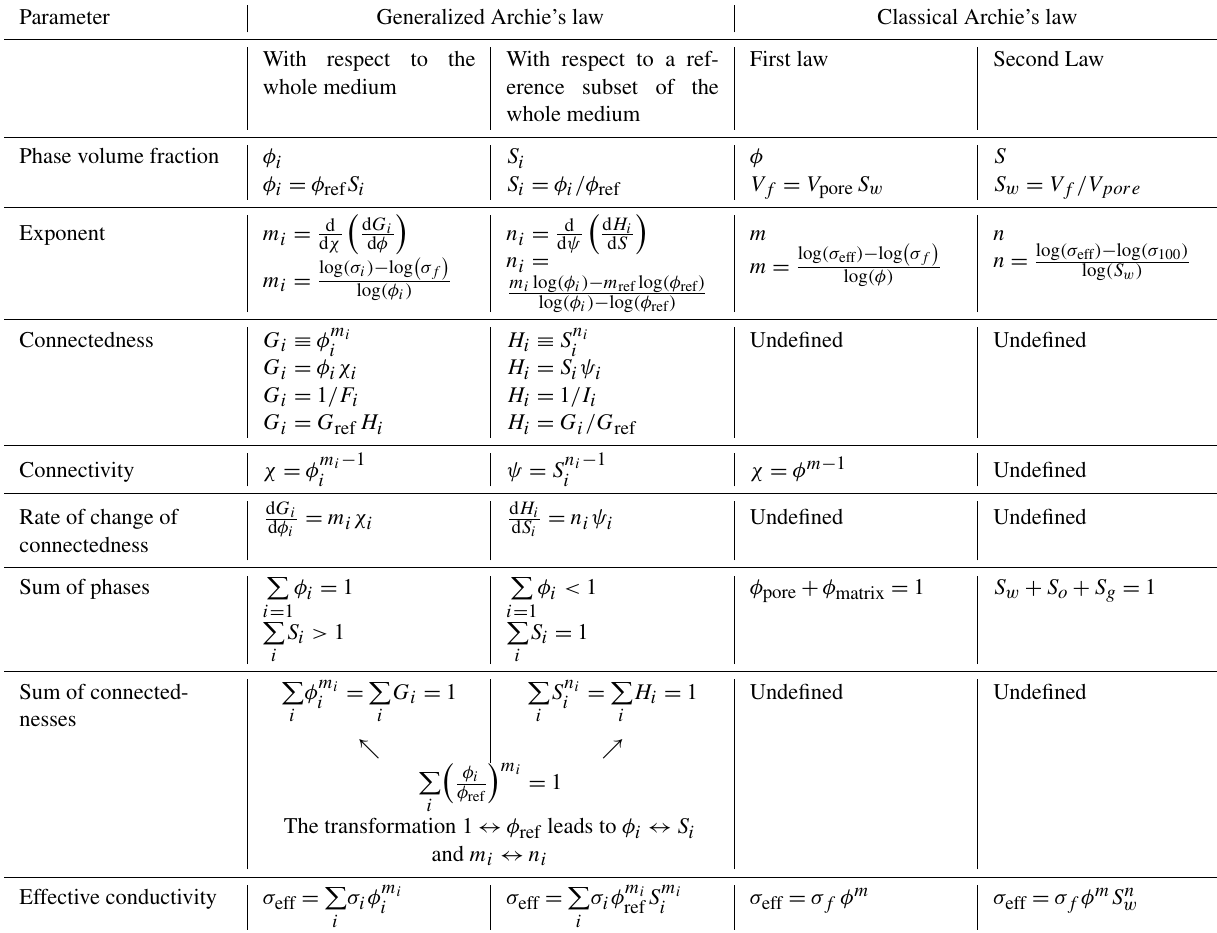
Table 1. Comparison of all the parameters in the classical and generalized Archie’s laws. Parameter Generalized Archie’s law Classical Archie’s law With respect to the With respect to a ref- First law Second Law whole medium erence subset of the whole medium Phase volume